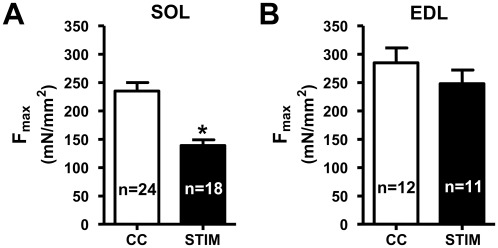
Fmax in skinned fibers from in vitro stimulated and non-stimulated SOL and EDL muscles.
A: Mean (+s.e.m) maximum specific Ca2+-activated force (‘Fmax’, expressed as mN/mm2) in skinned SOL fibers; number of fibers shown in bars. ‘STIM’ fibers from superficial regions of muscles stimulated in vitro as in Fig. 1C showed significantly lower Fmax than superficial fibers from the non-stimulated contralateral control muscles (CC fibers, P<0.05). Data obtained from pairs of contralateral muscles from 7 rats (6 Long Evans hooded and 1 Wistar). B: Fmax in superficial fibers from EDL muscles stimulated in vitro and matching control fibers (from 3 Long Evans hooded rats). ‘*’ denotes significantly smaller than CC fibers (P<0.05).